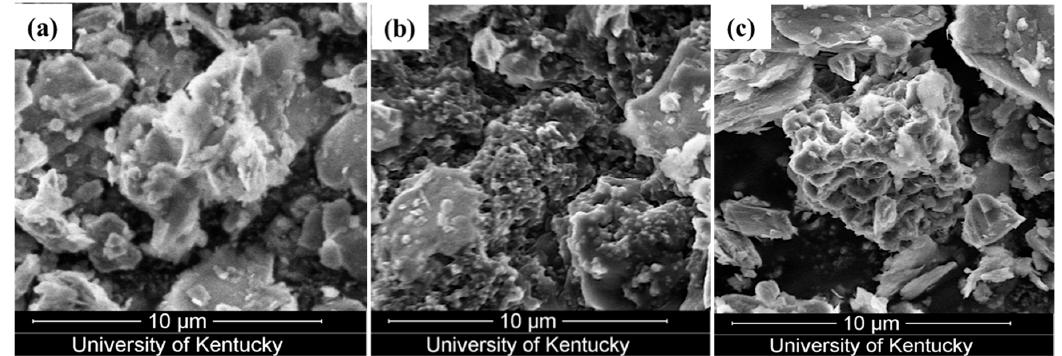
Figure 12. SEM images of particles found in ( a ) leaching feed material; ( b ) solid residue after 2 h leaching at 50 °C ; ( c ) solid residue after 2 h leaching at 75 °C (1 M H 2 SO 4 , 530 rpm, S/L = 10 g/L, D 80 = 8.7 μ m).